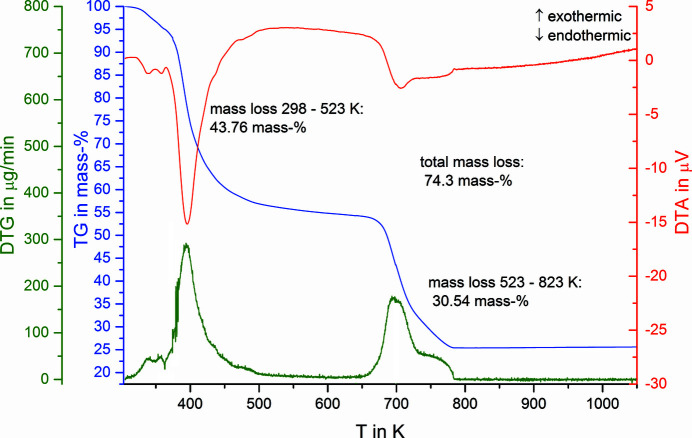
Thermal analysis of MgCO3·MgCl2·7H2O.